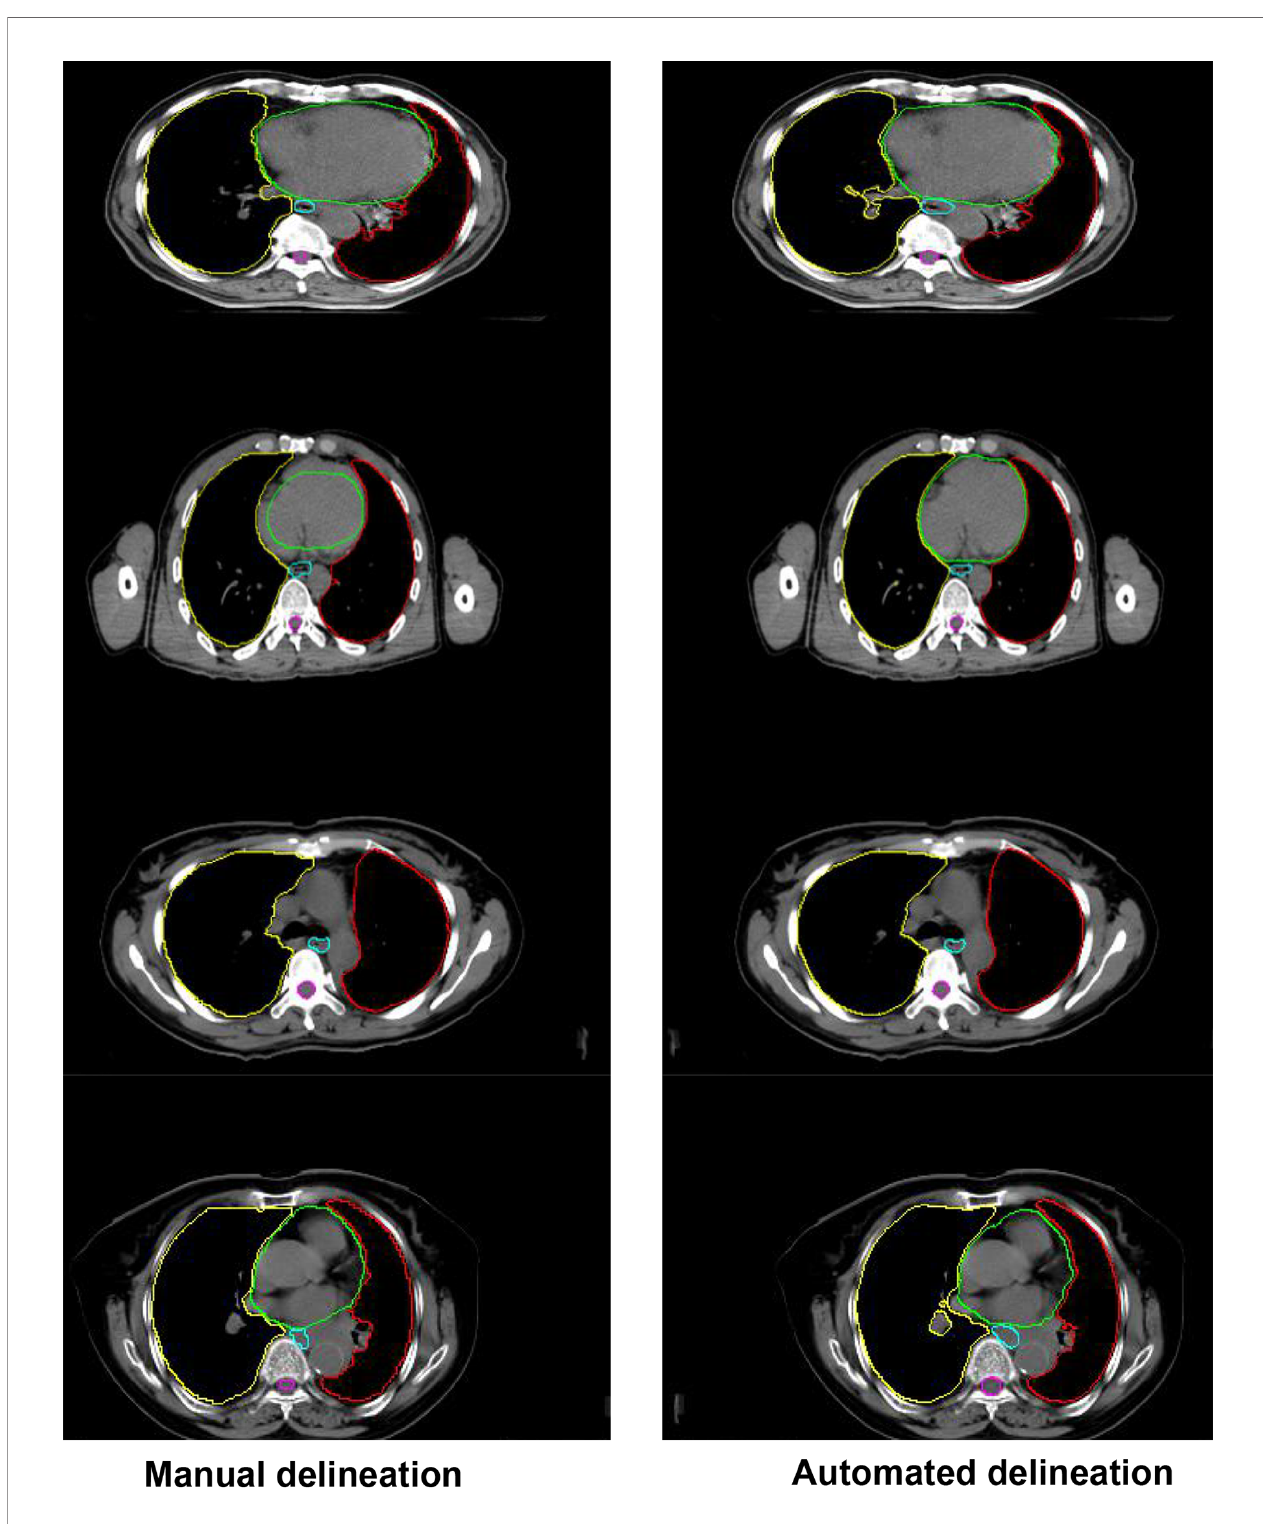
FIGURE 4 | The comparison between the automated segmentation delineation of some test cases and the manual delineation results of the radiologist. In the fi gure, each horizontal line lists a comparison of different test cases. The left side is delineated by physicians and the right side by the D-FCN4s model